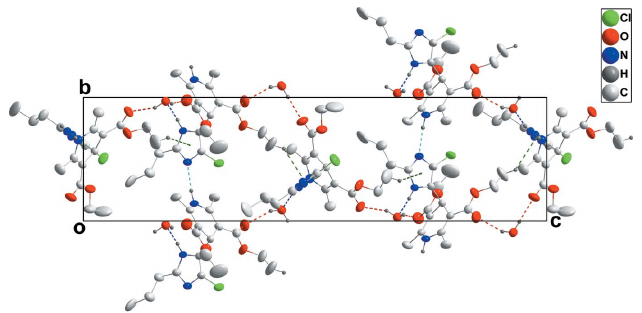
Figure 3 Packing viewed along the a -axis direction. O—H (cid:2)(cid:2)(cid:2) O hydrogen bonds are shown as red dashed lines while the N—H (cid:2)(cid:2)(cid:2) O and N—H (cid:2)(cid:2)(cid:2) N hydrogen bonds are depicted by dark- and light-blue dashed lines, respectively. The C—H (cid:2)(cid:2)(cid:2) (cid:2) (ring) interactions are depicted by green dashed lines.